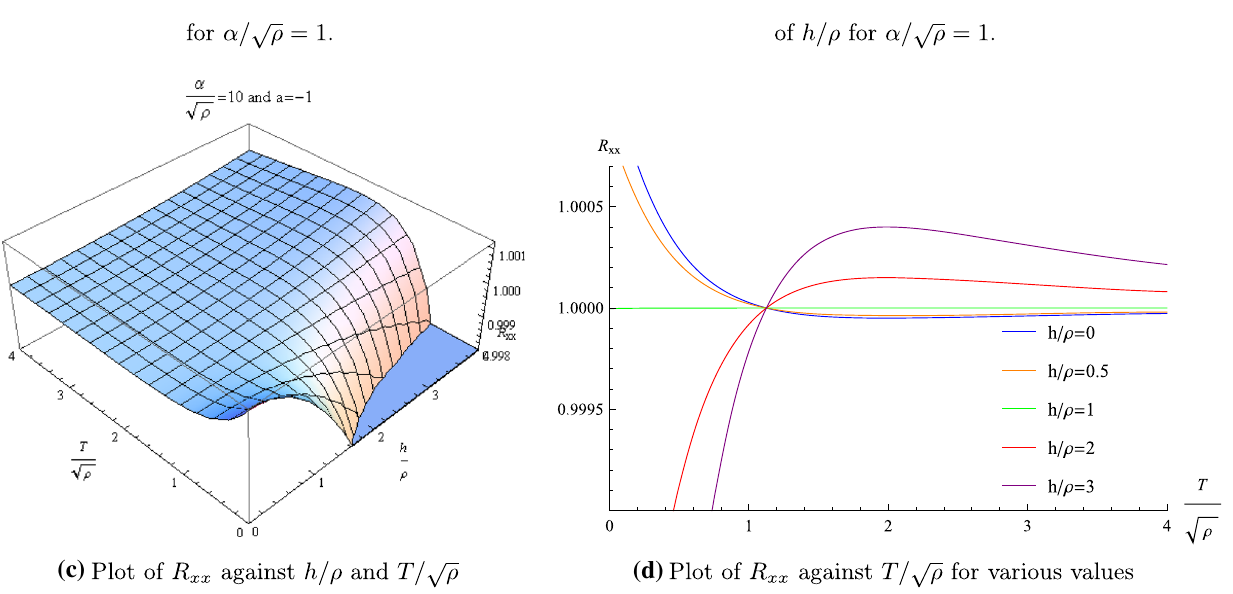
√ √ ρ = 1 and α/ ρ = 10 at finite charge density for Born-Infeld electrodynamics with